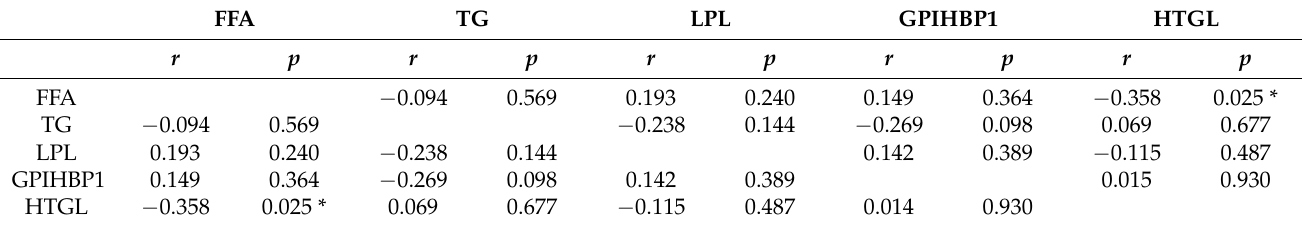
Table 2. Spearman’s correlation analysis of baseline FFA, TG, LPL, GPIHBP1, and HTGL concentrations at